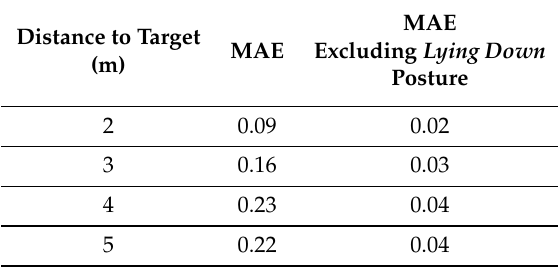
Table 13. Average counting errors of the detection component by